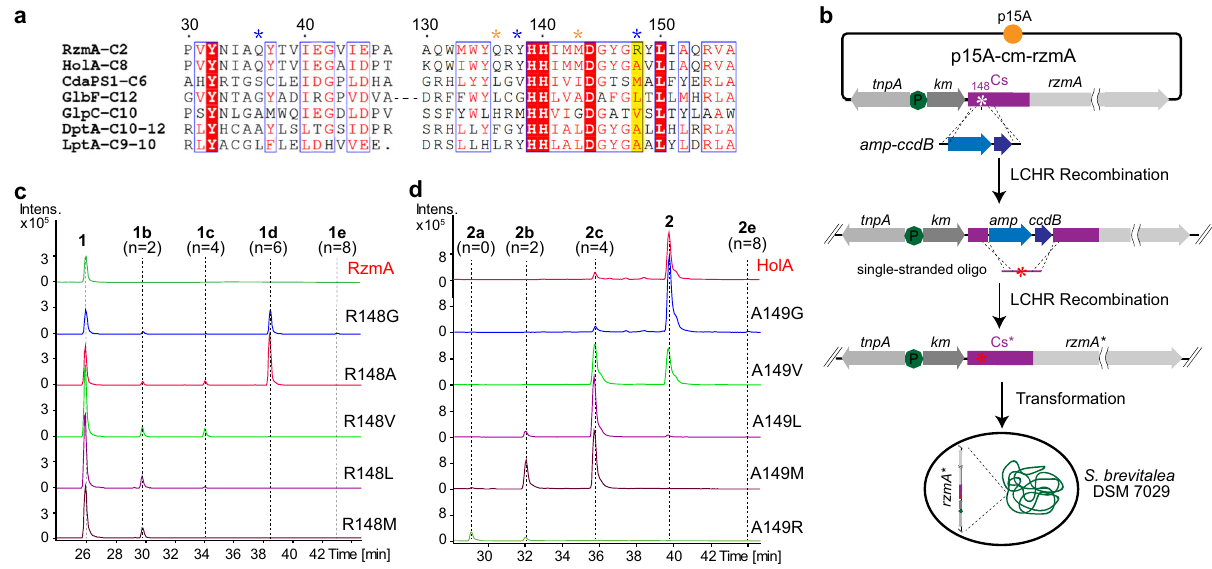
Fig. 4 Point mutations of a key residue in the RzmA-Cs and HolA-Cs domains. a Truncated sequence alignment of RzmA-Cs and HolA-Cs domains with other Cs domains loading different acyls. The asterisk-labeled residues represent key sites mentioned in the text for acyl substrate speci fi city (for details see Supplementary Fig. 4a). b The in vivo point mutation strategy of the rzmA -containing plasmid using CcdB counterselection recombineering 50, 51 The point mutations in holA were also performed in the same way. c , d Comparative production analysis of point mutations of RzmA R148 ( c ) and HolA A149 ( d ) to different residues in vivo showed gradient changes of the acyl chains of rhizomide and holrhizin, respectively. EICs at m / z = 732.391 ( 1 ), 760.421 ( 1b ), 788.452 ( 1c ), 816.483 ( 1d ), and 844.513 ( 1e ) for ( c ), and at m / z = 733.412 ( 2a ), 761.441 ( 2b ), 789.472 ( 2c ), 817.503 ( 2 ), and 845.537 ( 2e ) for ( d ). Wild-type RzmA and HolA expressed in S. brevitalea DSM 7029 are labeled in red. LCHR linear plus circular homologous recombination, amp-ccdB cassette of ampicillin resistance gene and CcdB toxin genes; tnpA and km are same as in Fig. 2. Full information was given in “ Methods ” section and Supplementary fi les.